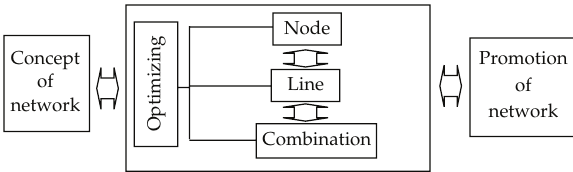
Figure 1: Coherent constituent parts of